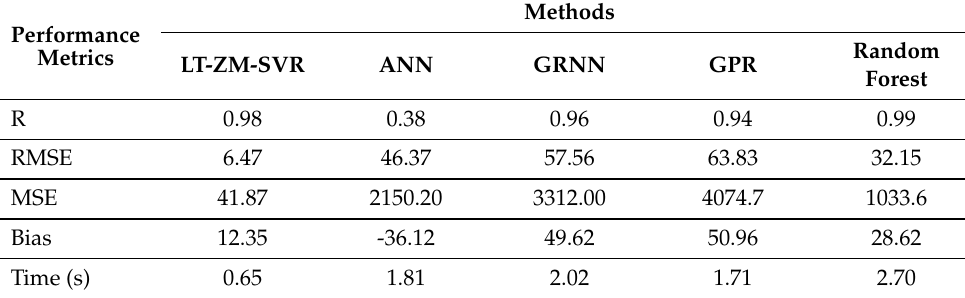
Table 3. Comparison of the proposed model with the benchmark algorithms.